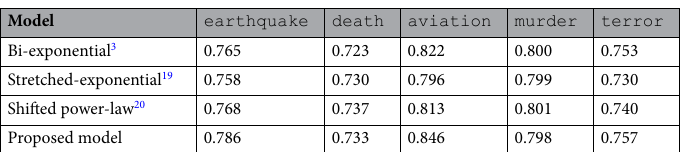
2 for four decay models.